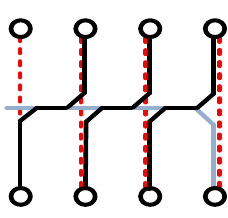
Figure 3. Fishbone with return line.